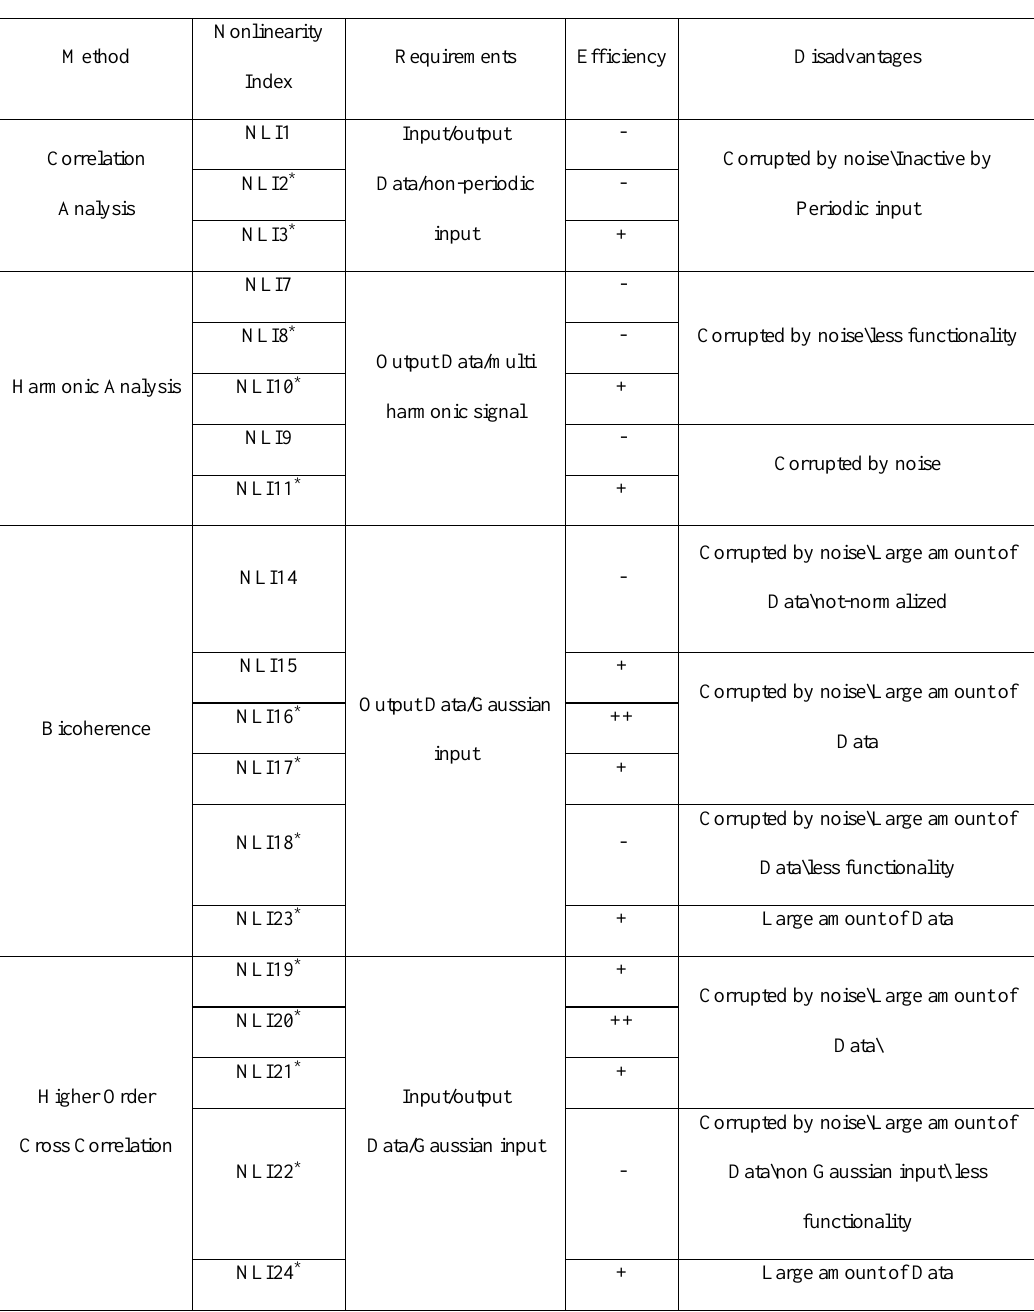
Table 1: Summary of different nonlinearity